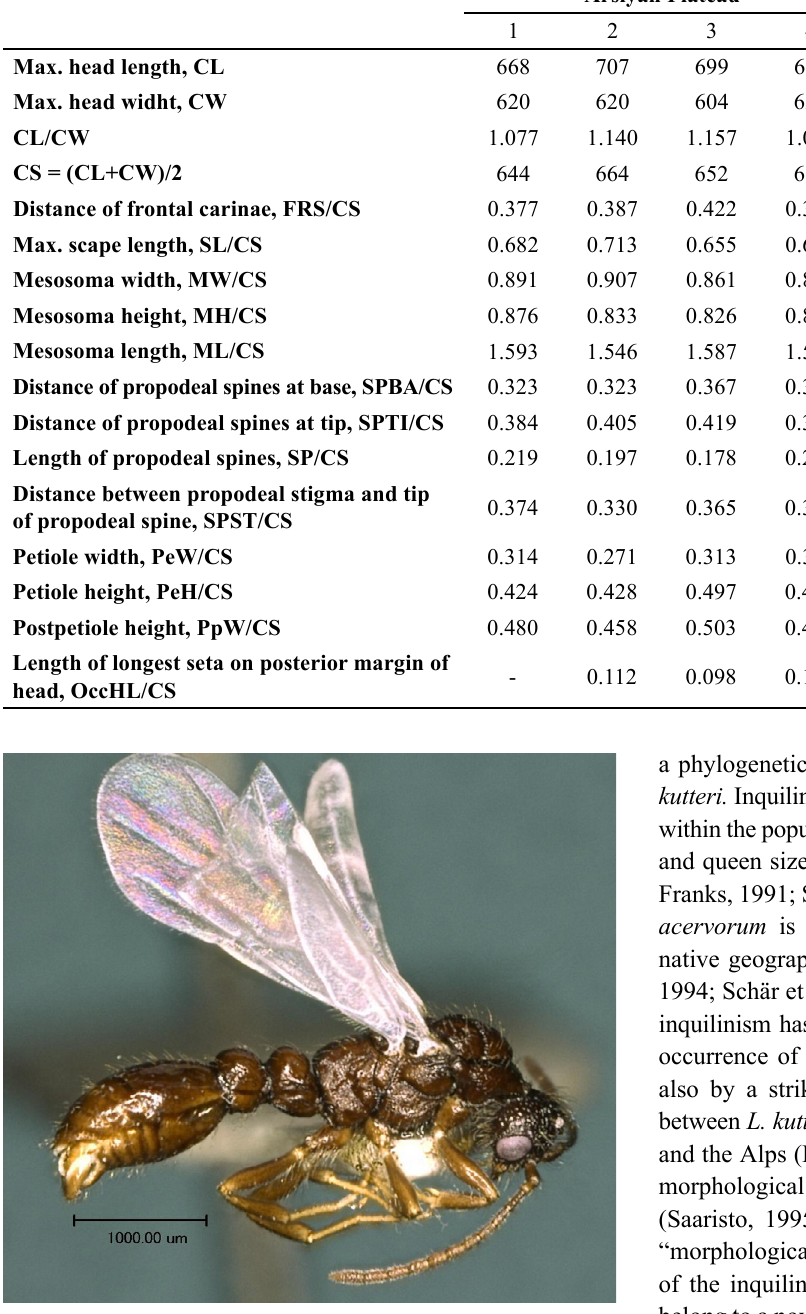
Fig 5 . Teratological male found together with a female sexual of the inquiline ant Leptothorax kutteri in Arıkmusa Village, Turkey.